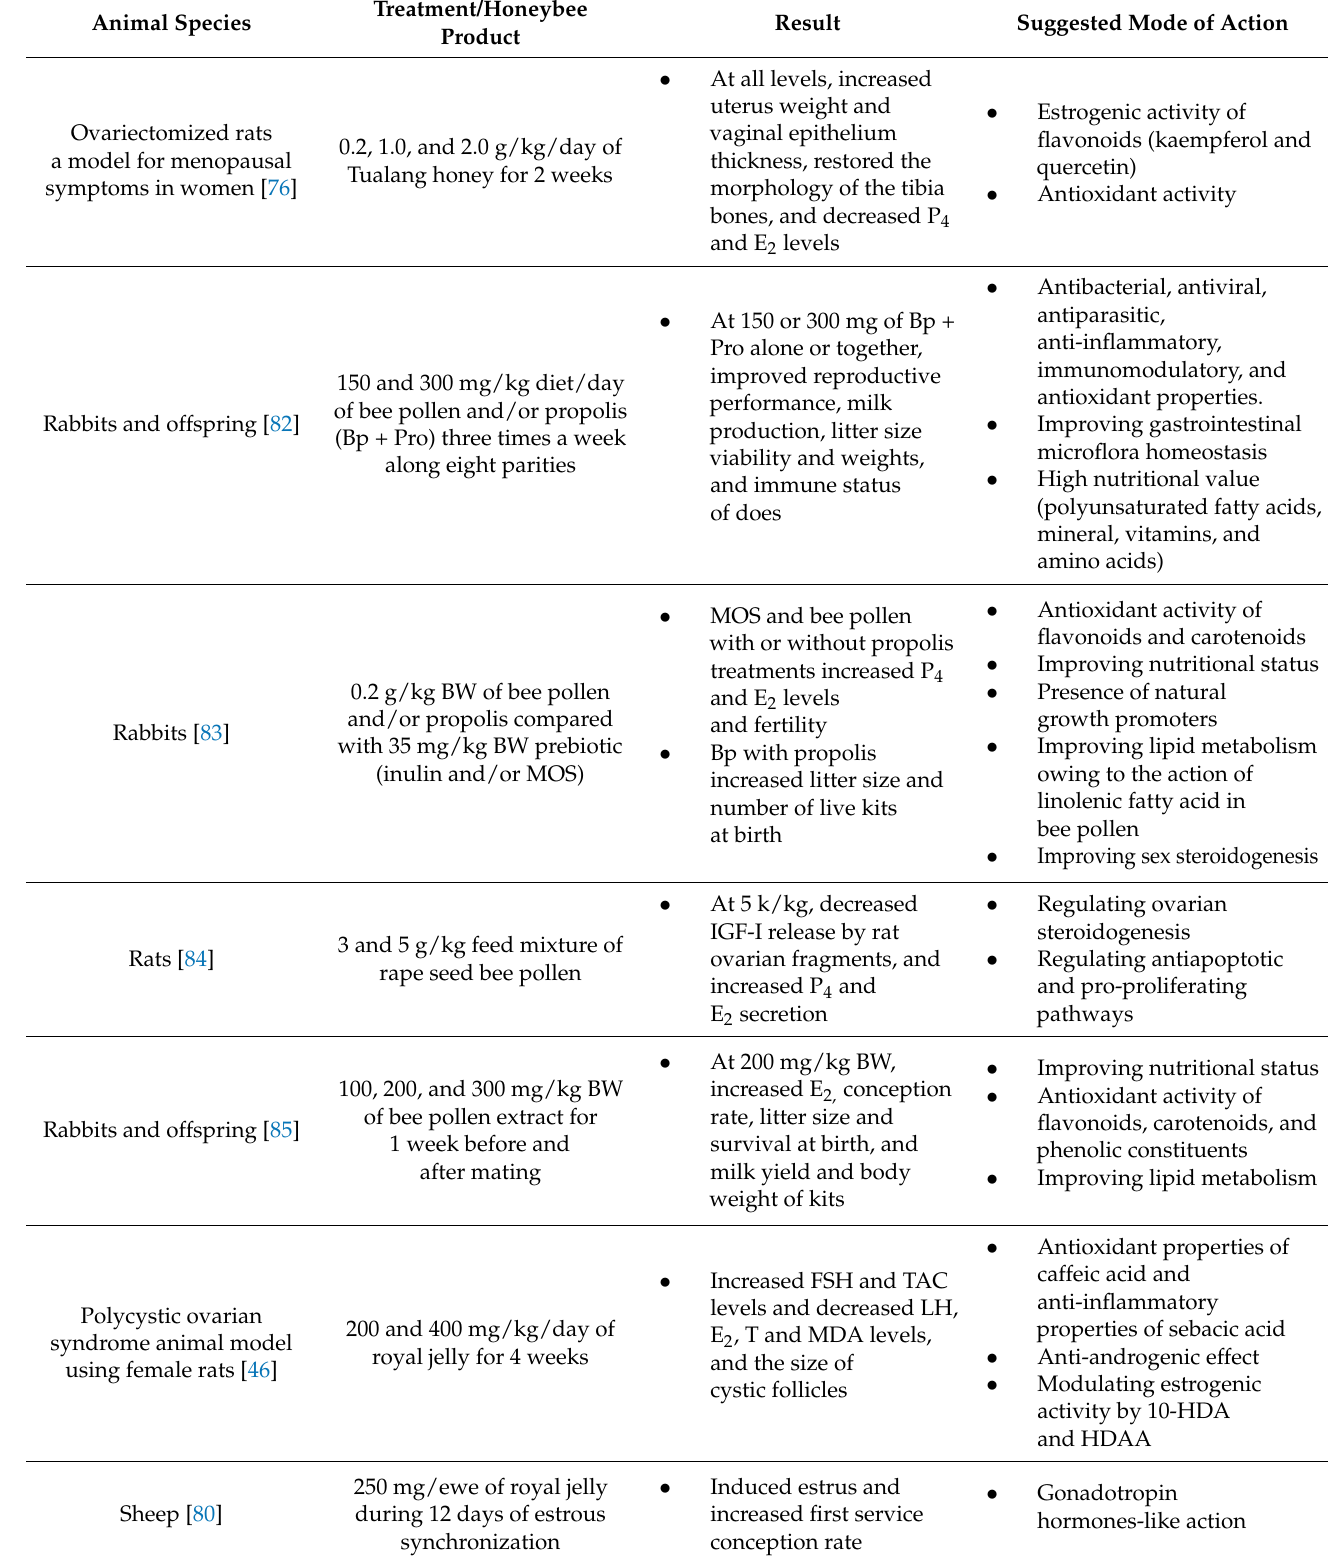
Table 4. Effect of bee products on reproductive performance of females of different mammalian